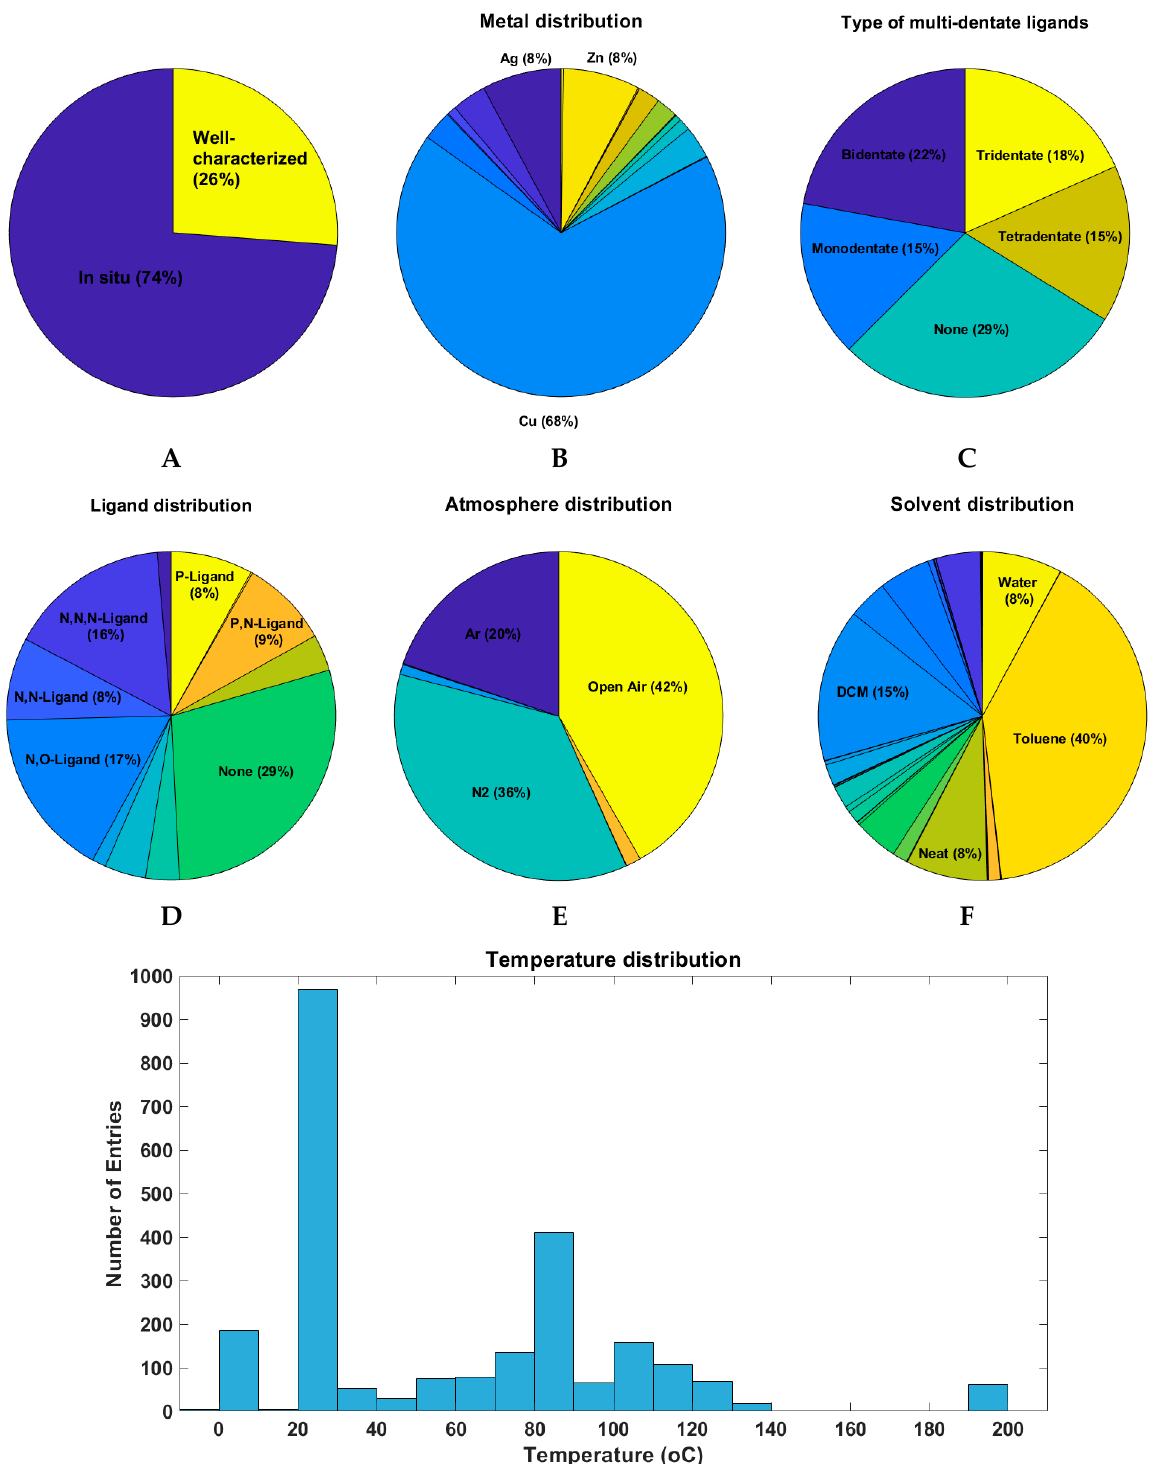
Figure 5. ( upper ) Distribution for in situ and well-characterised entries ( A ), metal distribution ( B ), type of ligand distribution ( C ), ( middle ) ligand distribution ( D ), atmosphere distribution ( E ), solvent distribution ( F ), ( lower ) temperature distribution.